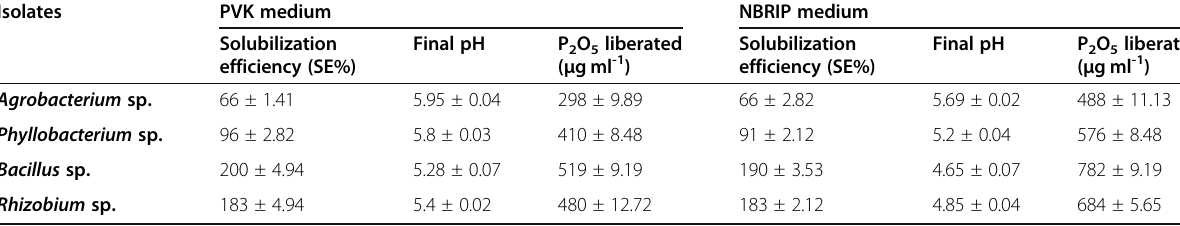
Rhizobium sp. Correlation coefficient between final pH and P 2 O 5 liberated ( r = − 0.95 in PVK; r = − 0.98 in NBRIP); between solubilization efficiency and P2O5 liberated ( r = 0.95) in both